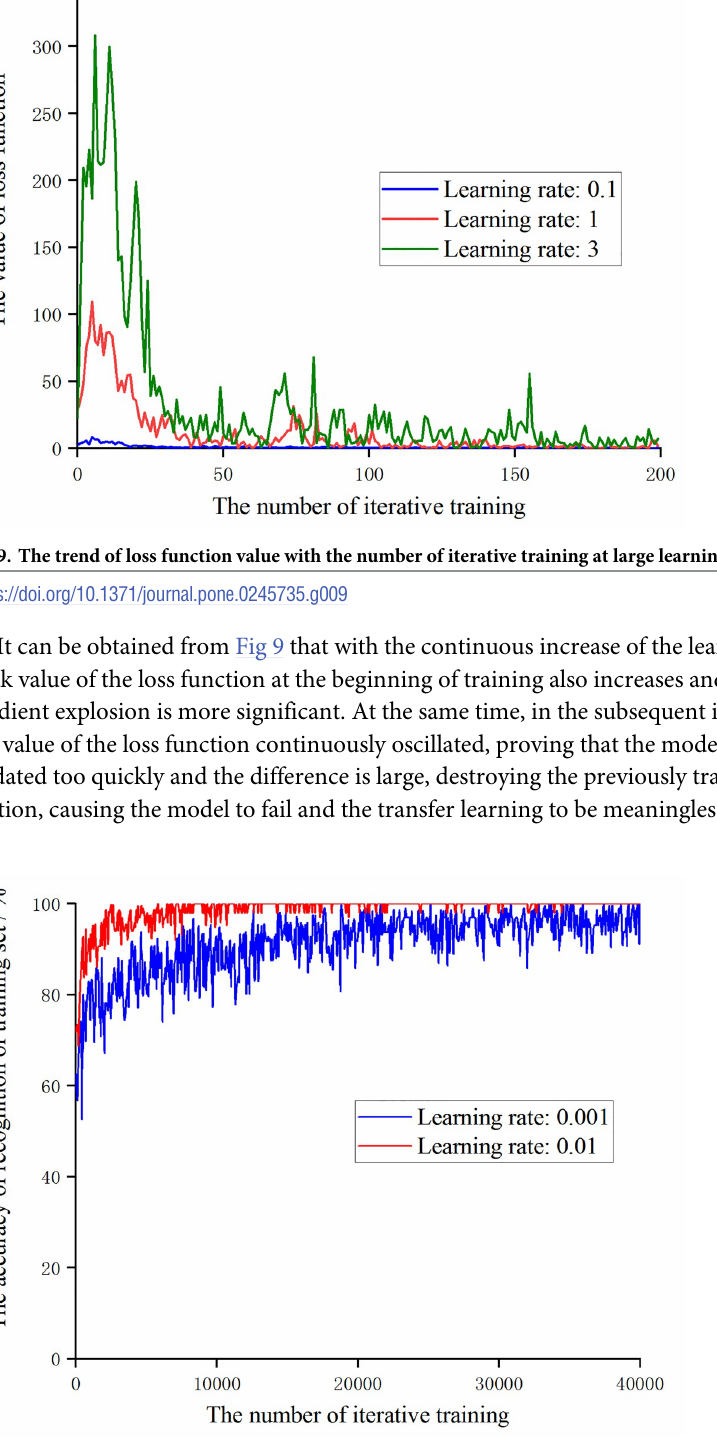
Fig 10. The trend of the accuracy of the training set with the number of iterative training at learning rates of 0.001 and